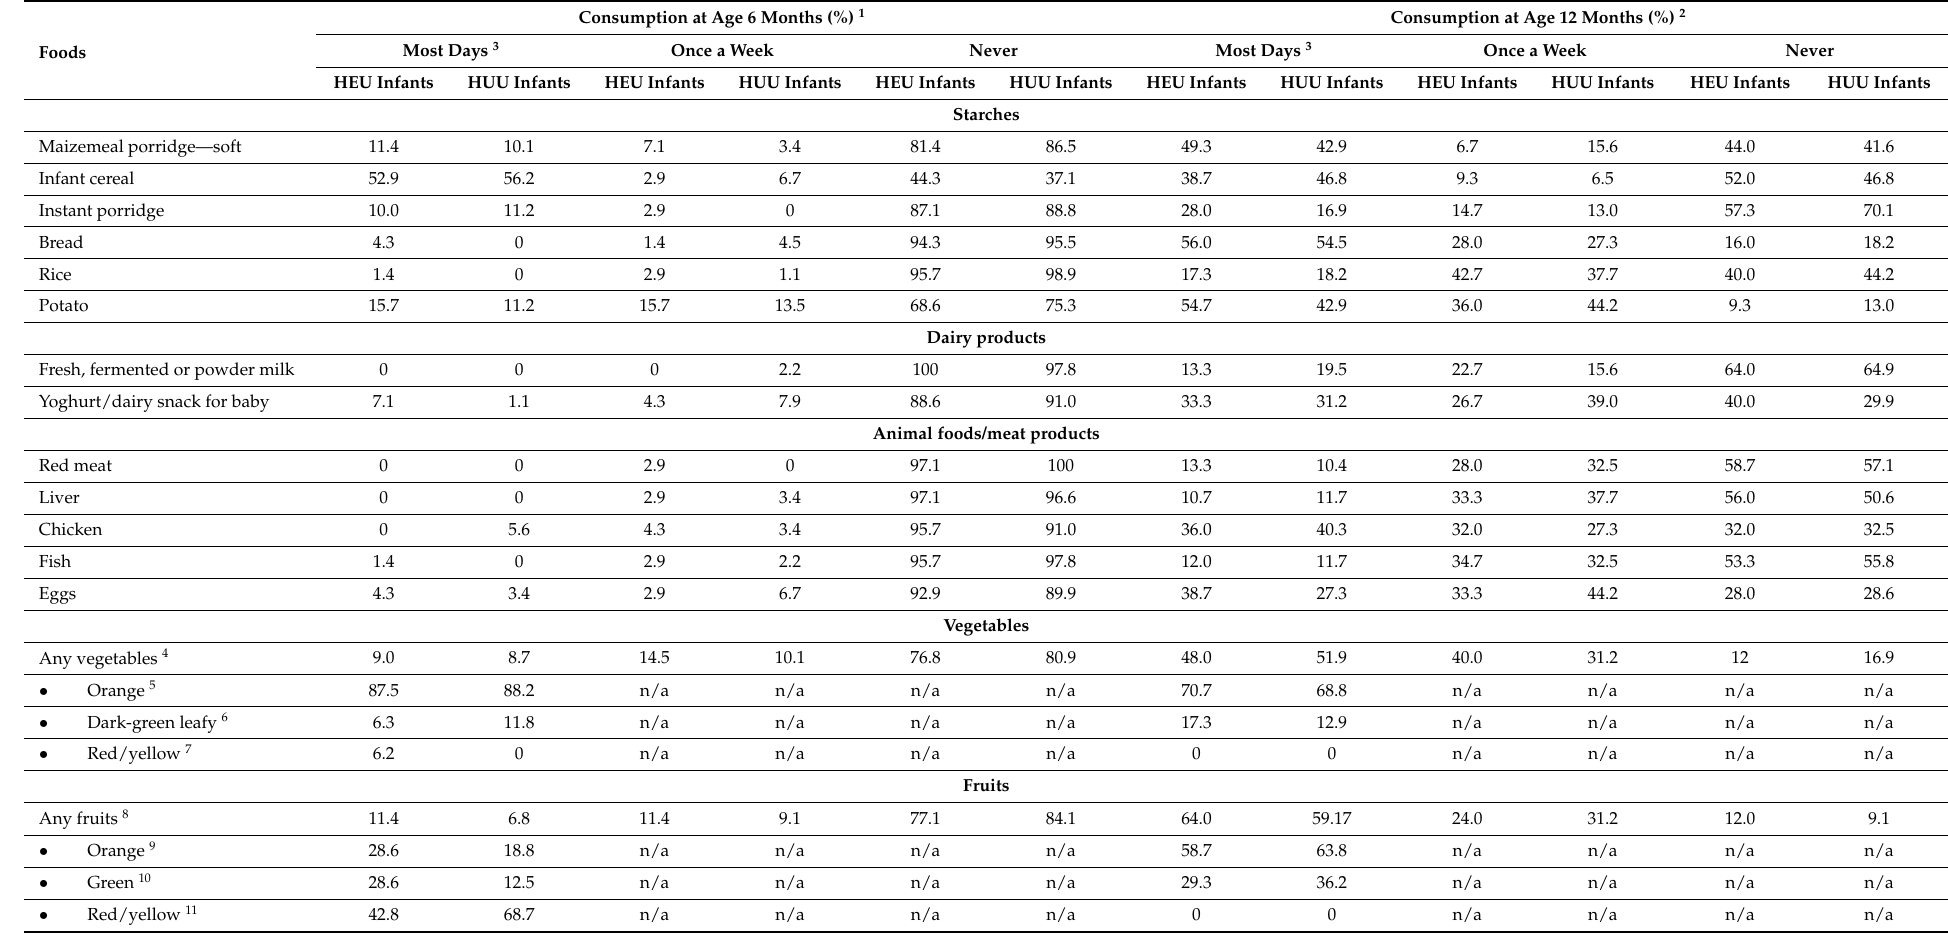
Table 4. Usual intake of food items by 6 and 12 months old HEU compared to HUU infants determined by quantified food frequency questionnaire